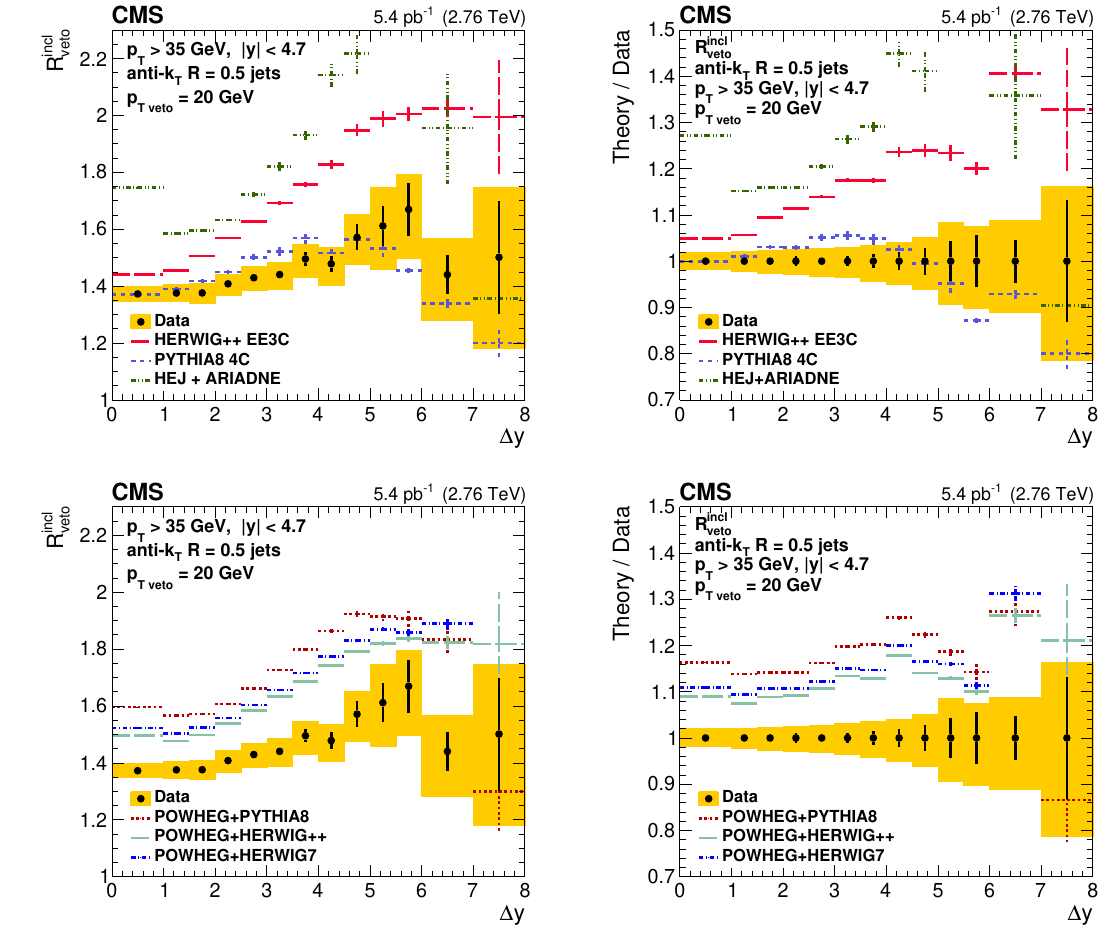
of the cross sections for inclusive to “exclusive” with veto dijet production. Figure 5 . Ratio R incl veto The upper and lower rows present the comparison with different MC models. The plots on the left present the ratio R incl and those on the right the ratio of theory to data. The systematic veto uncertainties are indicated by the shaded bands and the statistical uncertainties by the vertical